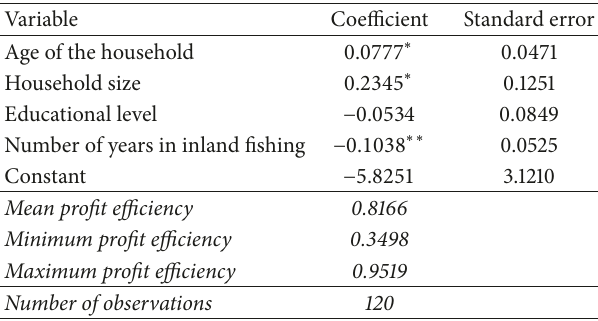
Table 3: Determinants of profit inefficiency of inland fishing in Pru District.